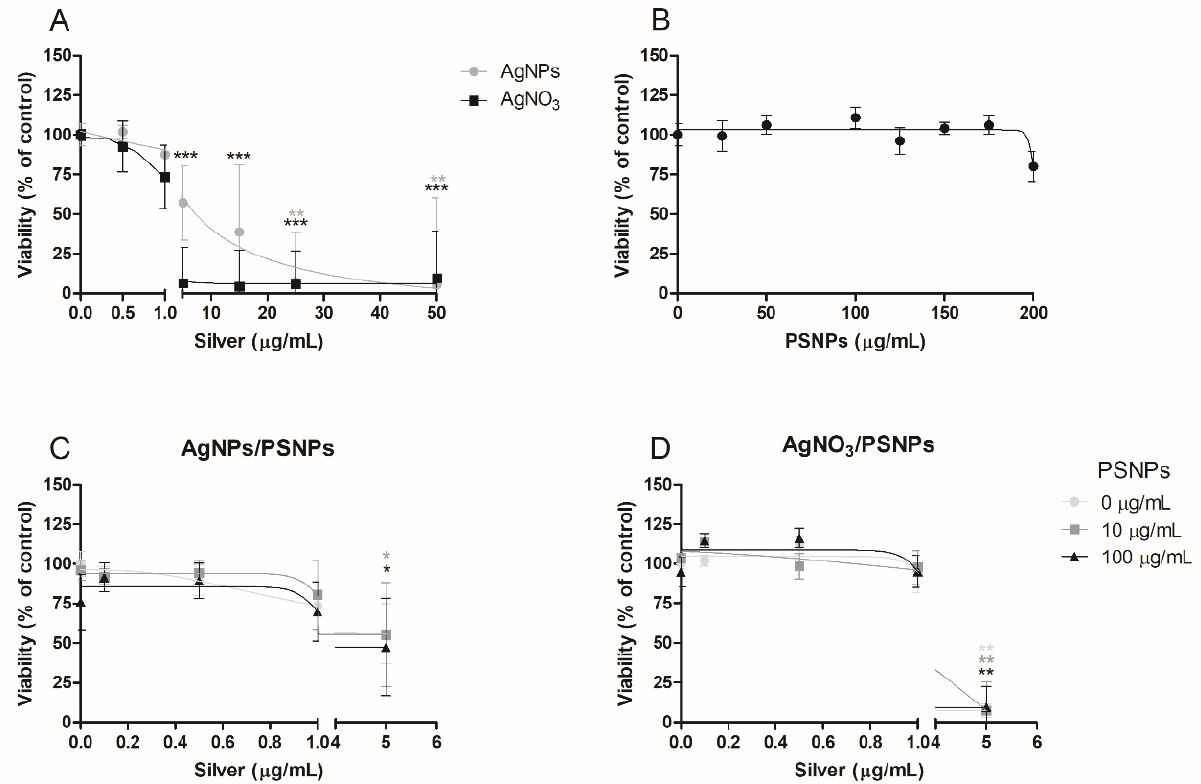
Figure 4. Relative viability of undifferentiated Caco-2 cells after 24 h of exposure to AgNPs or AgNO 3 ( A ), PSNPs ( B ), AgNPs/PSNPs ( C ), and AgNO 3 /PSNPs ( D ) at concentrations ranging from 0 to 50 µ g/mL for silver materials and PSNPs concentrations ranging from 0 to 200 µ g/mL. The viability percentages were calculated by averaging the number of cells counted for each condition in three independent experiments. Cell viability is represented as the percentage of counted cells compared to the untreated control ± SEM. Data were analysed by comparing each condition to the untreated control using Student’s t-test. * p ≤ 0.05, ** p ≤ 0.01, *** p ≤